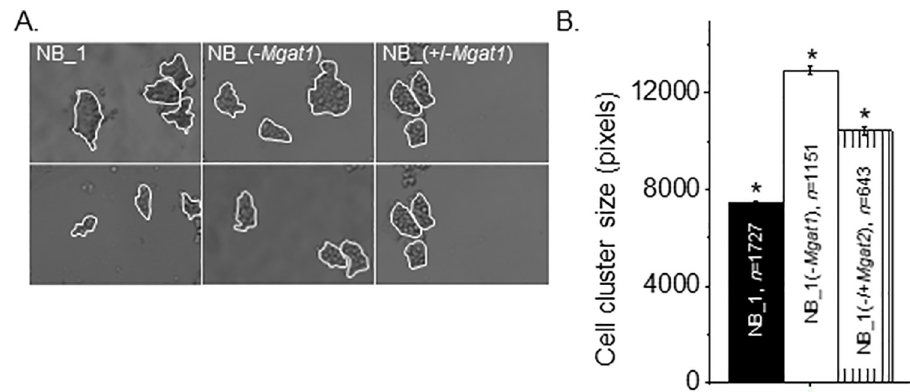
Fig 8. Modification of expression levels of Mgat1 impact cell-cell adhesion. (A) Selected DIC images obtained from NB_1 (left panels), NB_1(- Mgat1 ) (middle panels), and NB_1(-/+ MGAT1 ) (right panels) cell lines. Cell aggregates of more than 5 cells, as encircled in white, were analyzed. (B) The average area of cell aggregates from 3 cell dissociation experiments for each cell line. � P < 0.01. Mean differences were compared using One-way ANOVA followed by Holmes-Bonferroni’s test was used to compare differences in mean values. A value of P < 0.00000001 was considered significant ( � ). n signifies number of cell